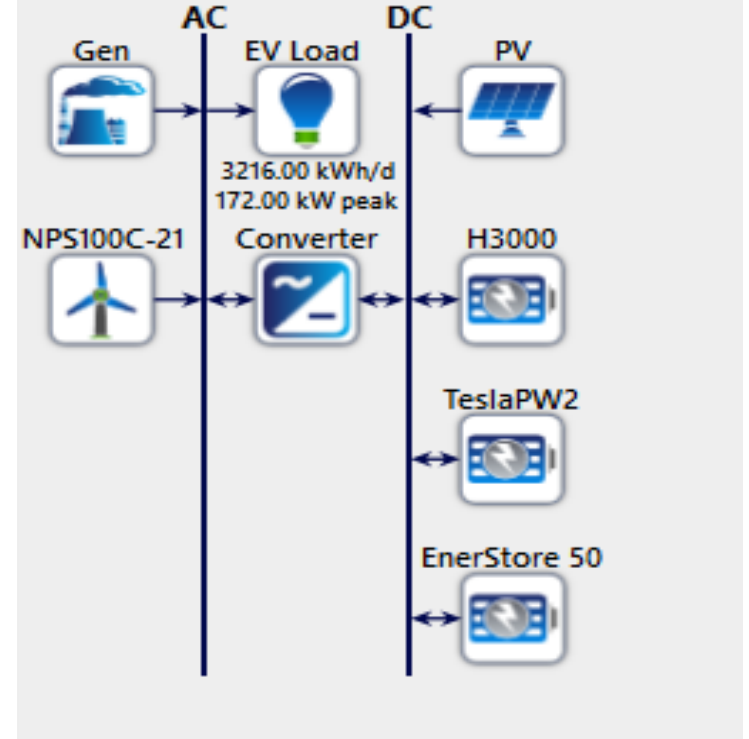
Figure 6. The schematic layout of the proposed hybrid system for application in the three cities.